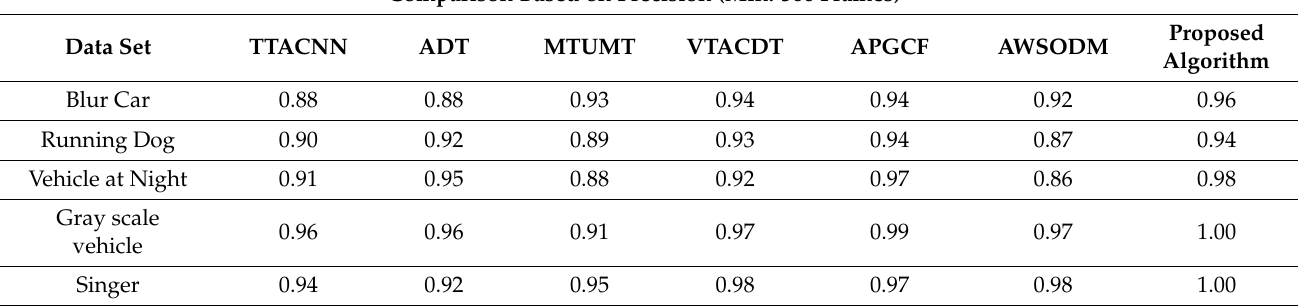
Table 3. Performance evaluation based on Precision. Comparison Based on Precision (Min. 300 Frames)